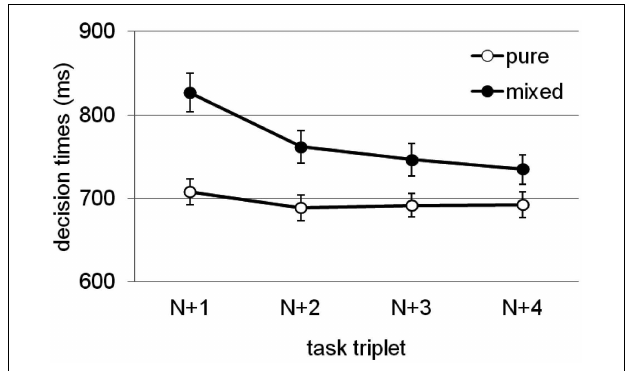
FIGURE 2 | Endurance of the bivalency effect: Mean decision times for task-triplets following a bivalent case decision in the mixed block (closed circles) compared with the corresponding task-triplets in the pure block. Error bars represent standard errors.Task-triplet N refers to the task-triplet containing a bivalent stimulus in the mixed block; subsequent task-triplets (represented here) are labeled N + 1, N + 2, N + 3, and N + 4, respectively. Results adapted from Meier et al. (2009), averaged across experiments, experimental conditions, and